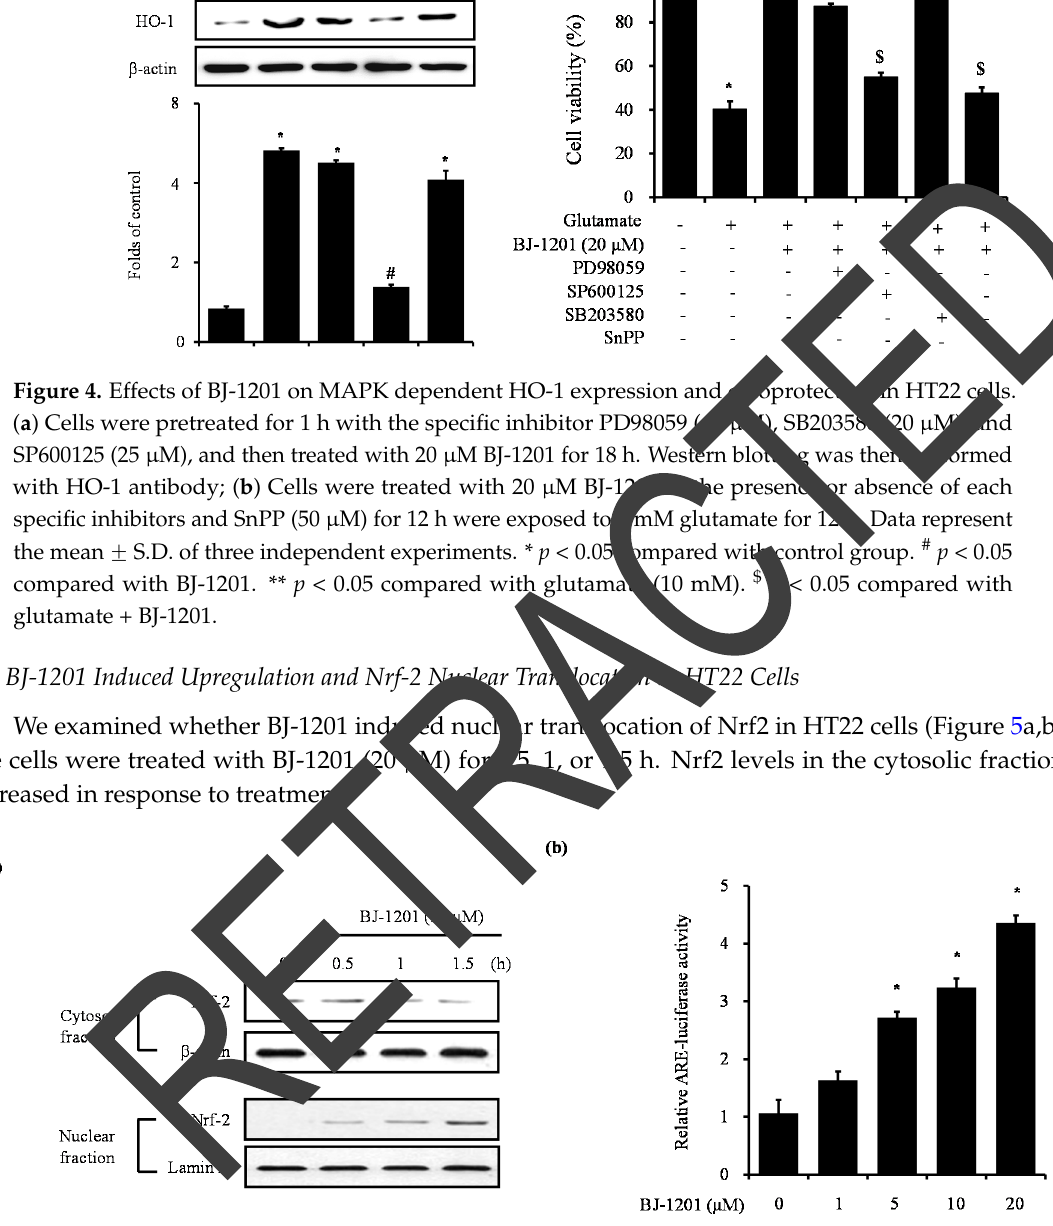
Figure 5. Effects of BJ-1201 on Nrf2 nuclear translocation in HT22 cells. ( a ) Cells were treated with 30 μ M BJ-1201 for 0.5, 1, and 1.5 h. Nrf2 protein was detected by western blot analysis; ( b ) Cells were transfected with ARE-luciferase of control vector were incubated for 1 h with the indicated concentrations of BJ-1201. Cells were assayed for luciferase activity as the fold induction by normalizing the transfection efficiency and dividing the values from each experimental sample relative to the control. Data represent the mean ± S.D. of three independent experiments. * p < 0.05 compared with control group.